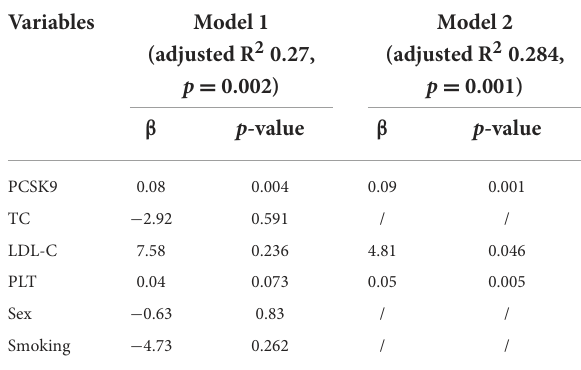
TABLE 2 Multivariate linear regression analysis of the association of ADP-induced MAR and